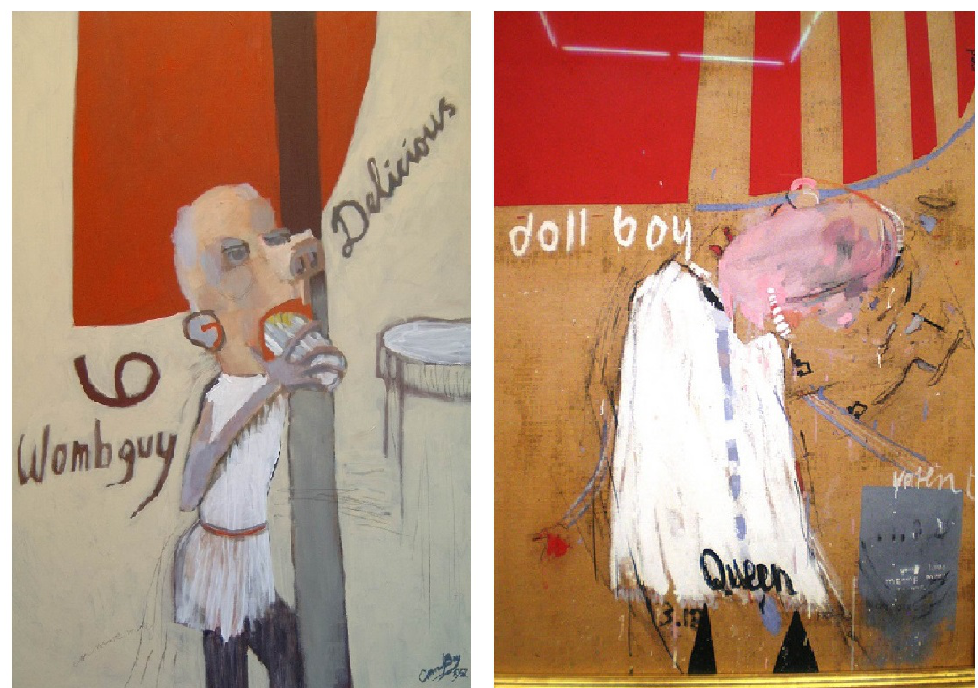
Figure 2: Conrad Boy: Womb Guy v. Doll Boy (David